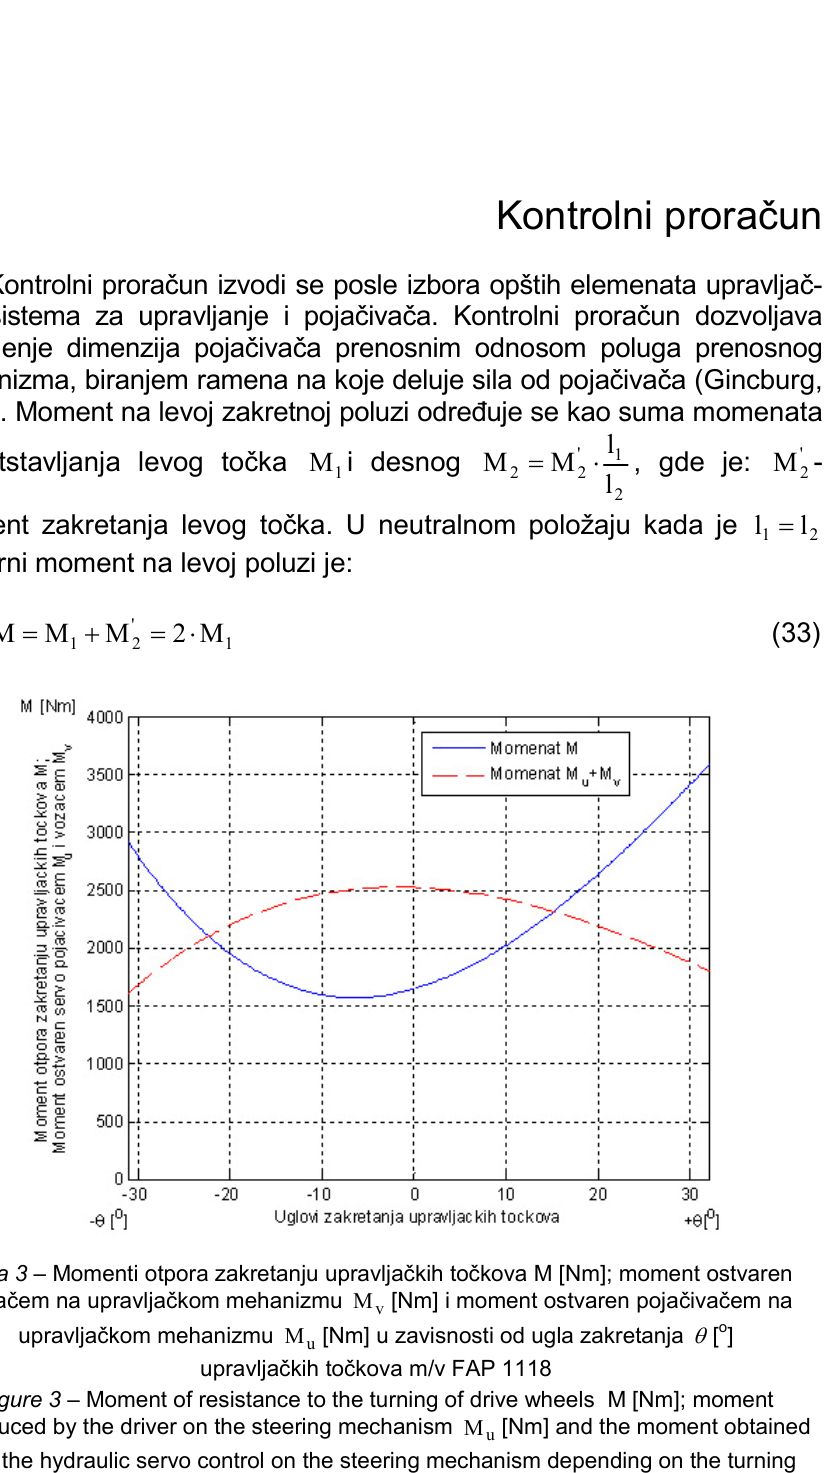
Figure 3 – Moment of resistance to the turning of drive wheels M [Nm]; moment introduced by the driver on the steering mechanism u M [Nm] and the moment obtained with the hydraulic servo control on the steering mechanism depending on the turning angle θ [ o ] of the drive wheels m/v FAP